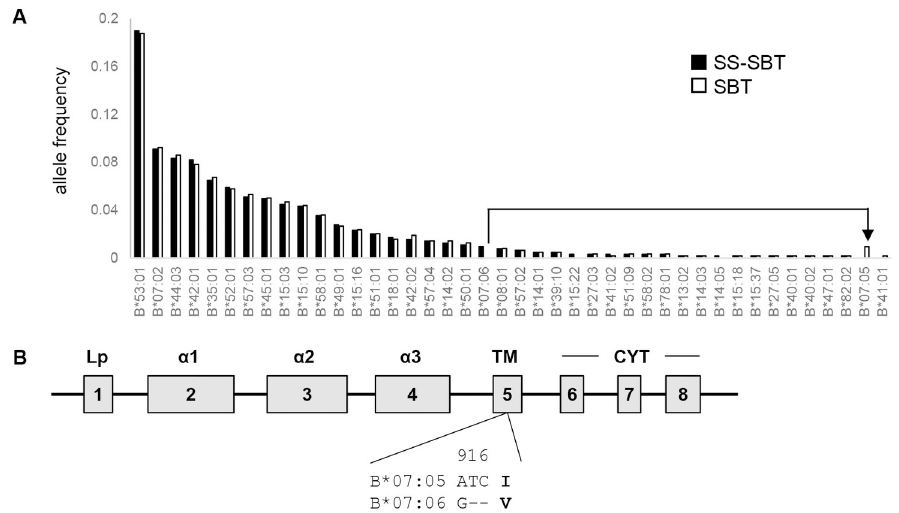
Fig 2. HLA-B allele frequencies in HIV-1 infected individuals in Ghana. A. HLA-B allele frequencies assigned by SS-SBT (filled) and SBT (open) are shown. An HLA allele pair showing discrepancy between the typing methods ( B � 07 : 06 by SS-SBT and B � 07 : 05 by SBT) is shown by an arrow-line. B. Schema of HLA class I gene structure. The difference in amino acid sequences between B � 07 : 05 and B � 07 : 06 is shown. https://doi.org/10.1371/journal.pone.0269390.g002 assigned as B � 07 : 05 by SBT (Fig 2A). In the HLA-C locus, C � 07 : 18 and C � 18 : 02 were assigned by SS-SBT in 28 and 24 samples (allele frequency: 4.3% and 3.7%), respectively, while these were assigned as C � 07 : 01 and C � 18 : 01 by SBT, respectively (Fig 3A). These mismatched alleles have only one nucleotide difference, and all of the polymorphisms were located in exons 5 and 6, out of the region for sequencing in SBT (Figs 1B, 2B and 3B). These results revealed